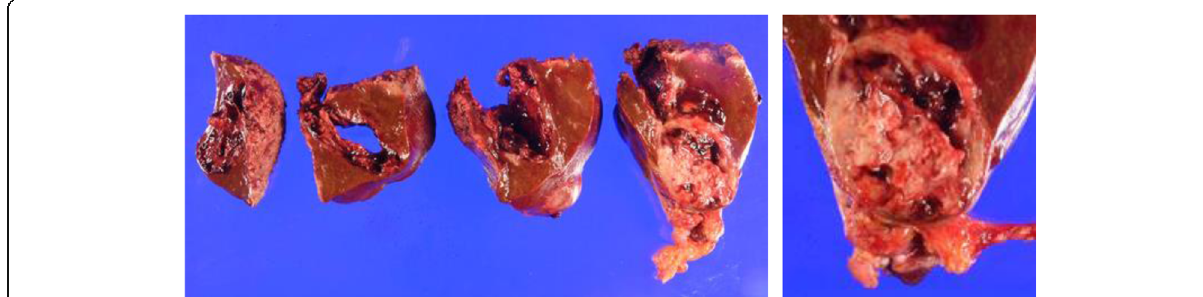
Fig. 5 Photograph of resected specimen. The tumor measuring 73 mm × 65 mm × 36 mm in the resected left lobe showed a 40-mm white solid component and a 22-mm black nodule adjoining